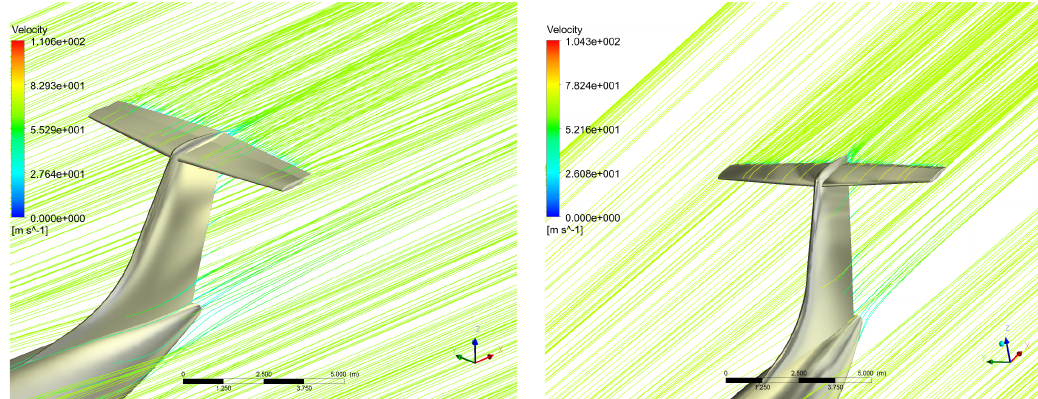
Figure 22. Elevators: mean flow streamlines for δ e = + 10 ◦ ( left ) and − 10 ◦ ( right